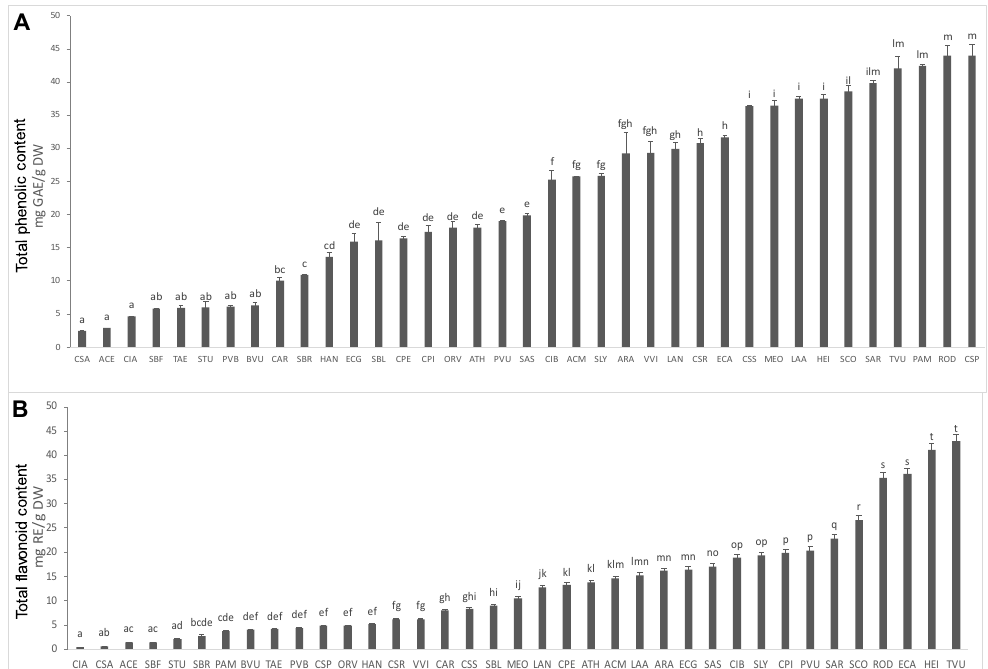
Figure 2. ( A ) Total phenolic content; ( B ) Total flavonoid content. The samples are indicated on the ‘x’ axis, while different letters within the same assay indicate significant differences in ANOVA tests ( p < 0.05). Results are expressed as means ± SD of three independent experiments.